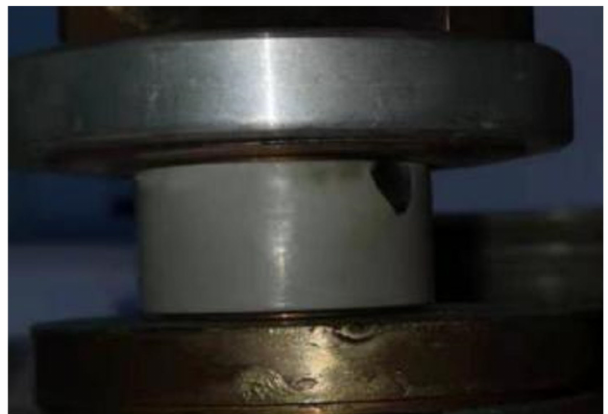
Figure 7. Surface breakdown of a varistor under a high current